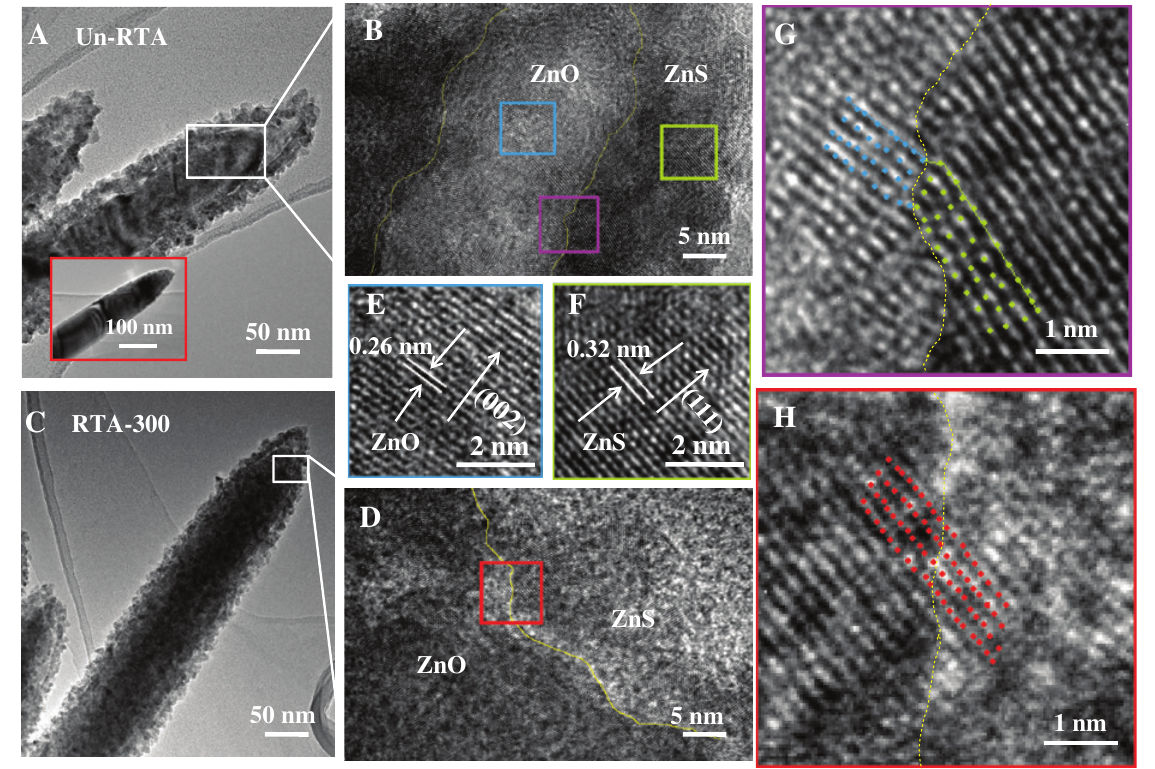
Figure 4: TEM images of individual NWs of (A) Un-RTA (the inset is the ZnO NWs) and (C) the RTA-300; (B) and (D) show the corresponding HRTEM images. The solid line in the HRTEM image in (B) and (D) marks the ZnO/ZnS NWs interface. The left half of the ZnO core is marked out with a blue square, and the right half of the ZnS shell is marked out with a green square; (E) and (F) are the enlarged phase images of the ZnO core and the ZnS shell from the marked area of image (B). (G) and (H) Close-up HRTEM images of the interface between the ZnO core and the ZnS shell, showing the stacking grain boundaries and fluctuations of atoms in space as well as the ZnOS phase at the interface area.